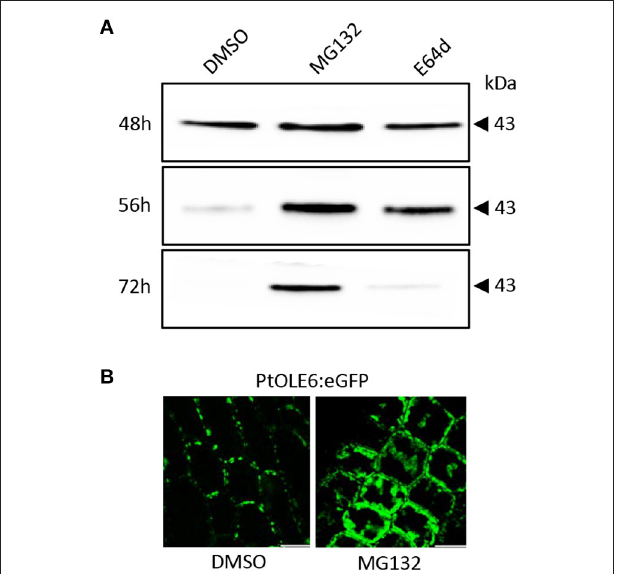
FIGURE 3 | PtOLE6 degradation by the proteasome pathway. (A) MG132 inhibits proteasomal degradation of PtOLE6 in germinating Arabidopsis seeds. Arabidopsis PtOLE6-eGFP overexpressor seeds were germinated in DMSO control, MG132, and E64d for 48–72h, and immunodetected using an anti-eGFP antibody. (B) Treatment with MG132 prevents degradation of PtOLE6-eGFP, resulting in cytosolic accumulation in epidermal cells of the hypocotyl adjacent to the radical. DMSO, control. Bar 50 µ m. FIGURE 4 | Expression of genes involved in OLEOSIN degradation. Relative